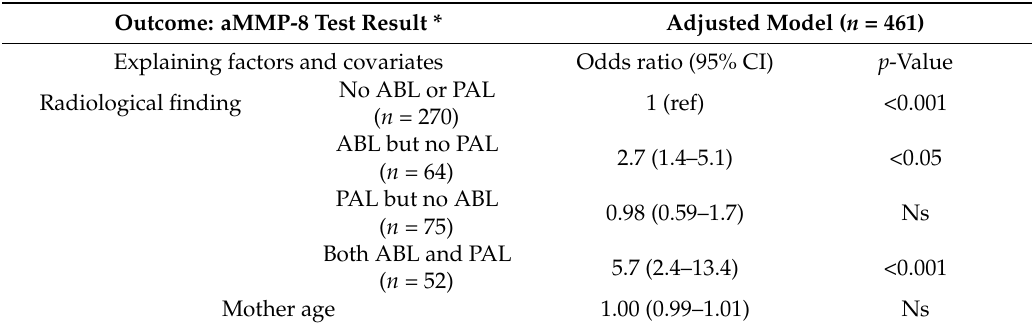
Table 4. Logistic regression model on association between the radiological findings and aMMP-8 test results adjusted by mother age.